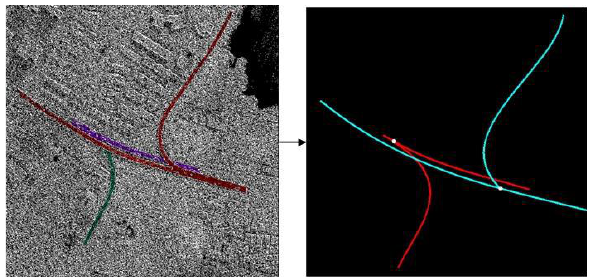
Figure 10. Topology Reconstruction